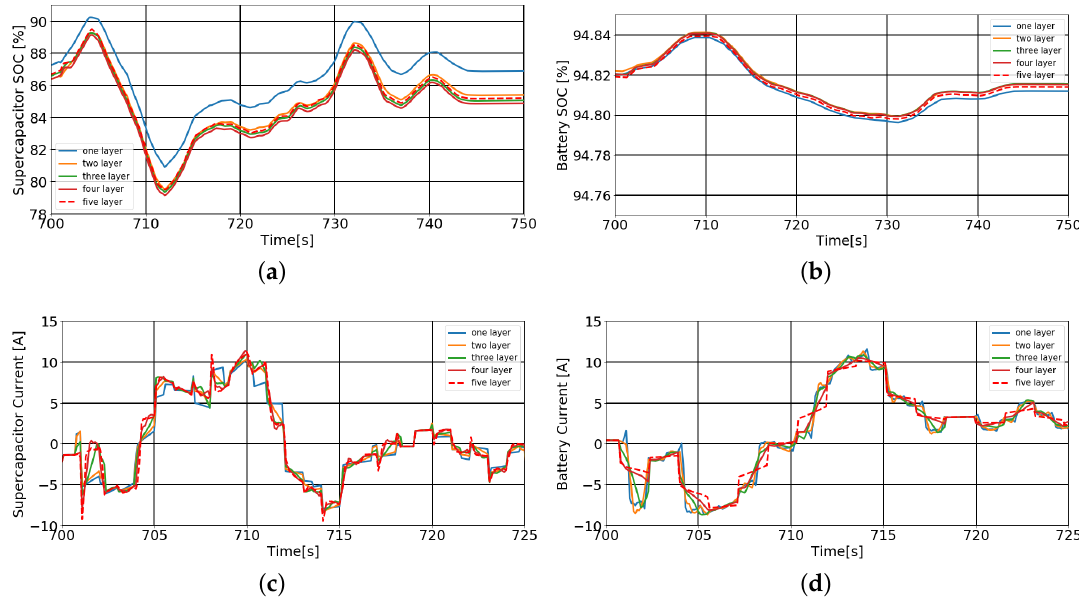
Figure 5. The results of the wavelet transform of 1–5 layers are performed on the driving cycle LA92. ( a ) The state of charge (SOC) profiles of the batteries; ( b ) the SOC profiles of the supercapacitors; ( c ) the current profiles of the batteries; ( d ) the current profiles of the